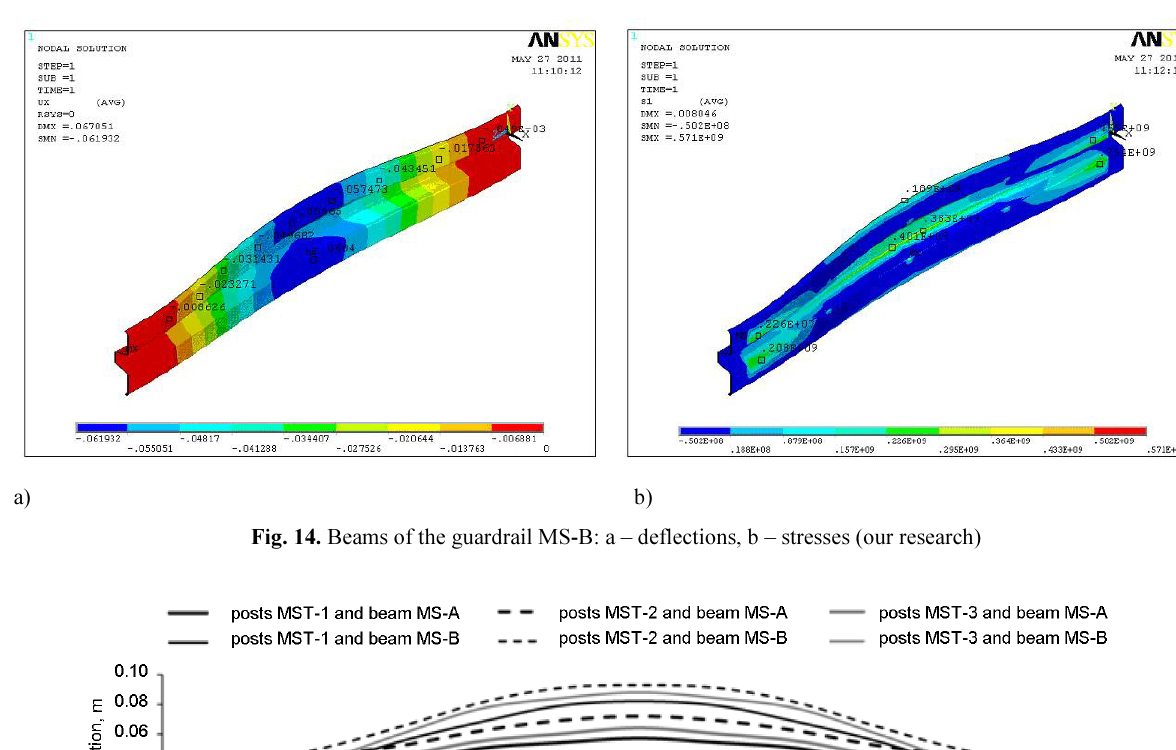
Fig. 13. Beams of the guardrail MS-A: a – deflections, b – stresses (our research)